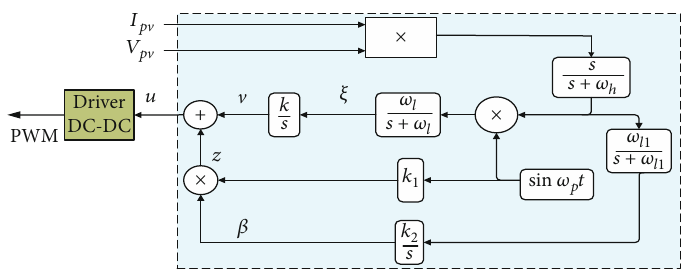
Figure 9: Block diagram of the modi fi ed ESC algorithm applied to the PV system.